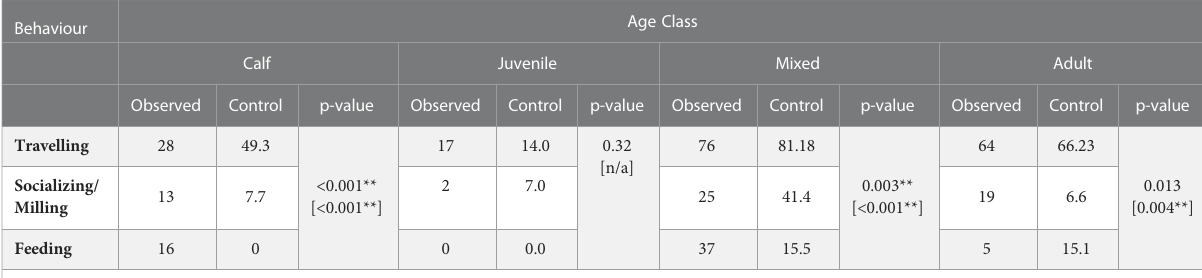
TABLE 6 Comparison of the frequency of beluga behaviour by age class in the presence (observed) and absence (control) of vessels for all years combined.